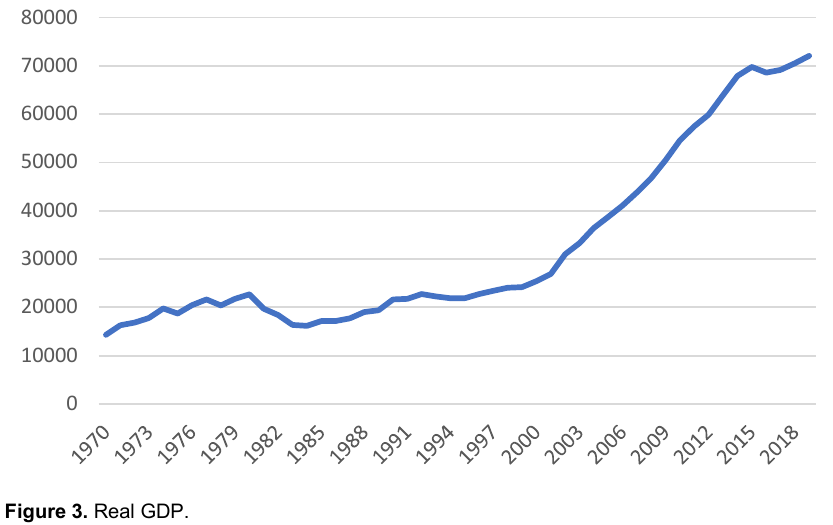
Figure 3. Real GDP.